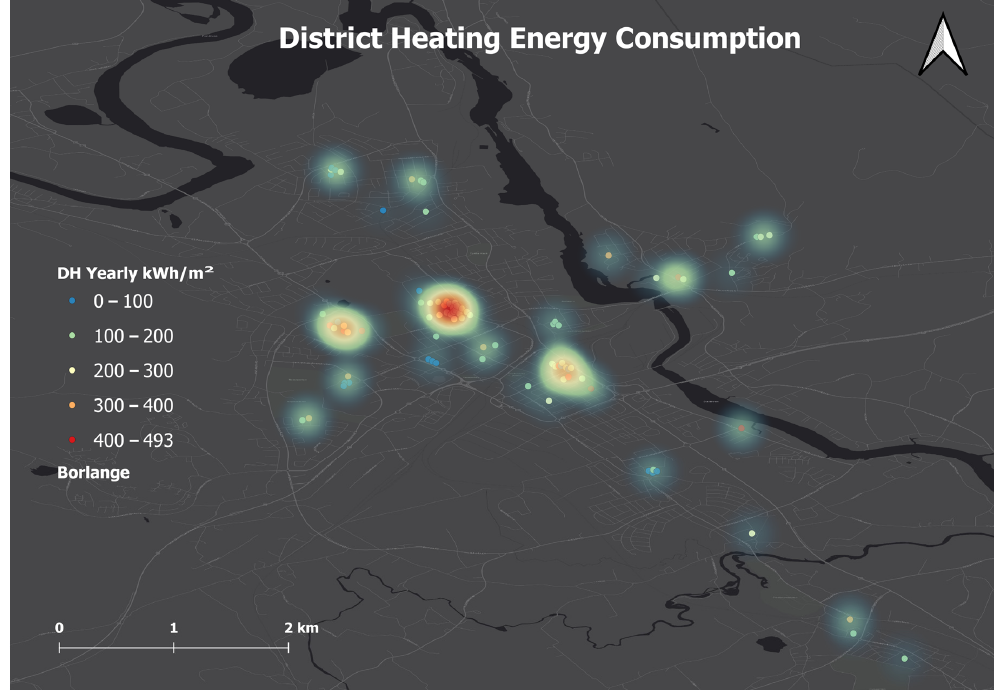
Figure 7. Digital mapping of heating demand in Borlänge city based on building samples.